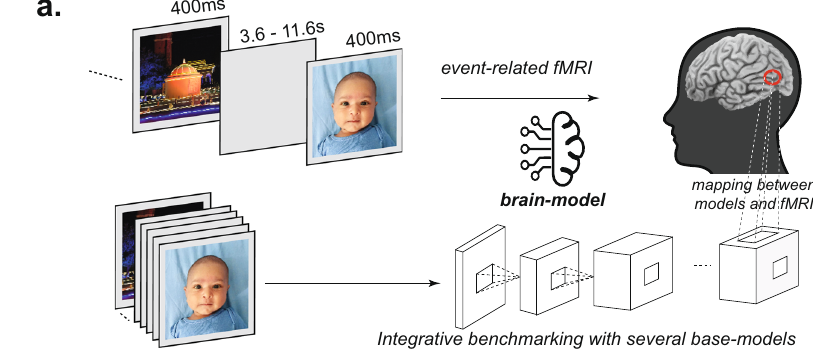
Fig. 1 Outline of experiment design, fROI modeling. a Experiment design and fROI modeling. BOLD responses to each image were collected using an event-related fMRI experiment ( top ), and the functional ROIs (FFA, EBA, PPA) were de fi ned in each subject using an independent functional localizer (schematically outlined on the brain in red). The same images were then fed to several candidate image-computable models (base-models, below). Using a subset of stimuli, we learn a linear mapping (right) from each model to each brain region (see Methods) to build a brain model for each region based on each CNN model. The brain-models for each region were then evaluated based on the ability to predict the responses to held-out images not used in the mapping (integrative benchmarking). Note that images here are used only for illustrative purposes and are not the actual images used in the experiment. Permission was obtained from the parents of the person in the photograph to publish the image used in this fi